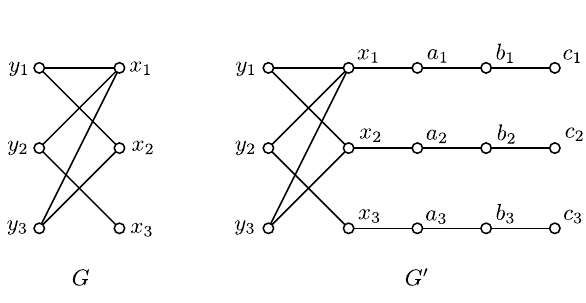
Fig. 6: A bipartite graph G and the graph G (cid:48) obtained from G